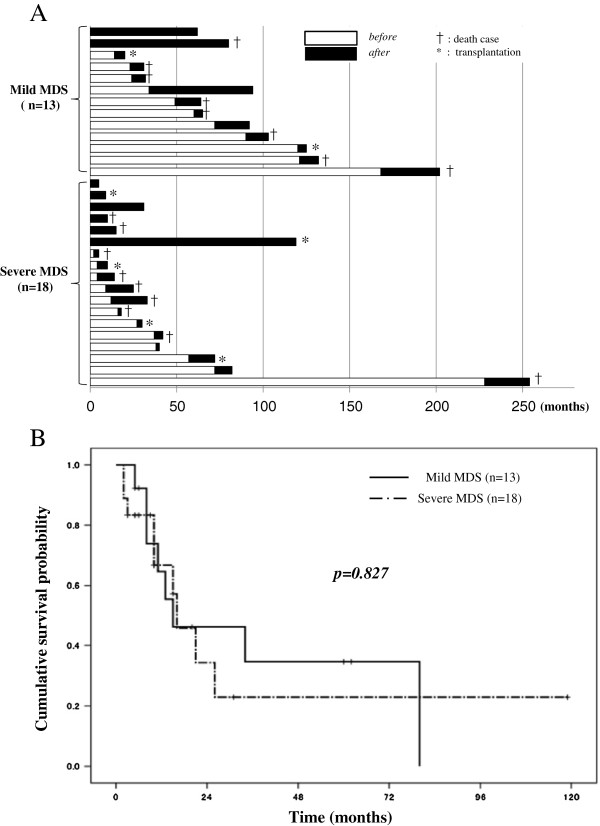
Disease duration of secondary PAP in patients with MDS. A: Duration of disease before or after the diagnosis of secondary pulmonary alveolar proteinosis (sPAP). The horizontal axis indicates the month after the diagnosis of myelodysplastic syndrome. The open column and closed column indicate the duration of disease respectively before and after the diagnosis of sPAP. The case that resulted in death is marked by † and the case that underwent transplantation therapy is marked by *. B: Cumulative survival probability after diagnosis of secondary PAP (sPAP) in patient groups with mild myelodysplastic syndrome (MDS) (n = 13) and severe MDS (n = 18). The horizontal axis indicates the month after the diagnosis of sPAP, and the vertical axis indicates the cumulative survival probability.